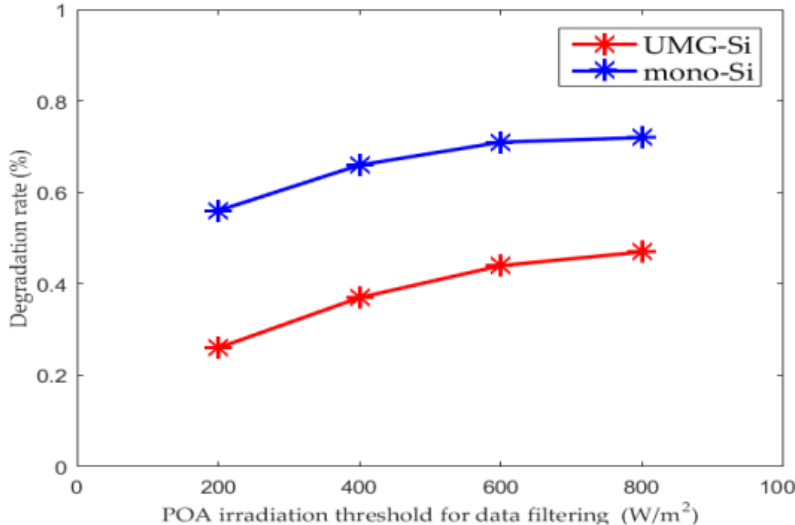
Figure 13. Degradation rate with different thresholds for data filtering